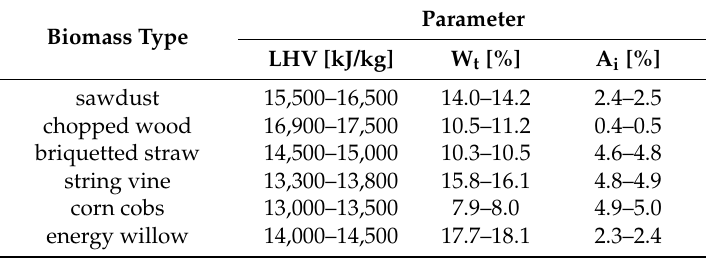
Figure 10. Measuring devices: ( a ) gas analyzer and data acquisition system; ( b ) exhaust gases analyzer.